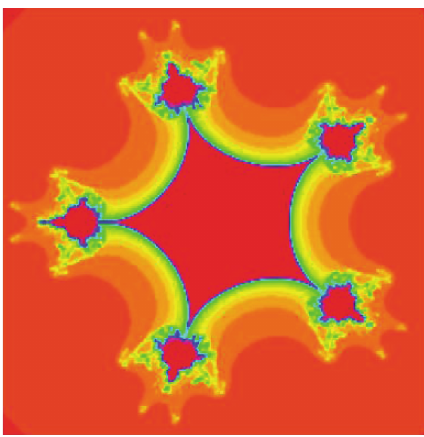
Figure 19: Relative superior multicorn for 𝑠 = 0.01 , 𝑠 󸀠 = 0.4 , and 𝑛 = 5 .